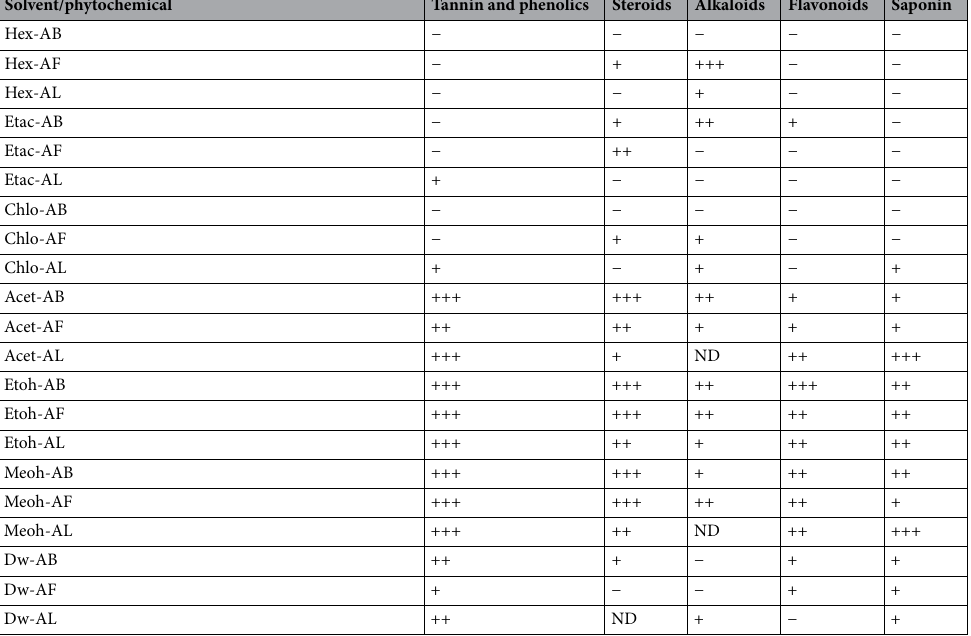
Table 1. Qualitative phytochemical analysis of solvent extracts of T. arjuna +++, high concentration; ++, moderate concentration; +, low concentration; ND, not detected, table showed that Etoh-AB showed a higher profile for tannins and phenolic, alkaloids and flavonoids. Similarly, high polar solvent extracts also showed better profiling as compared to apolar and aprotic solvent